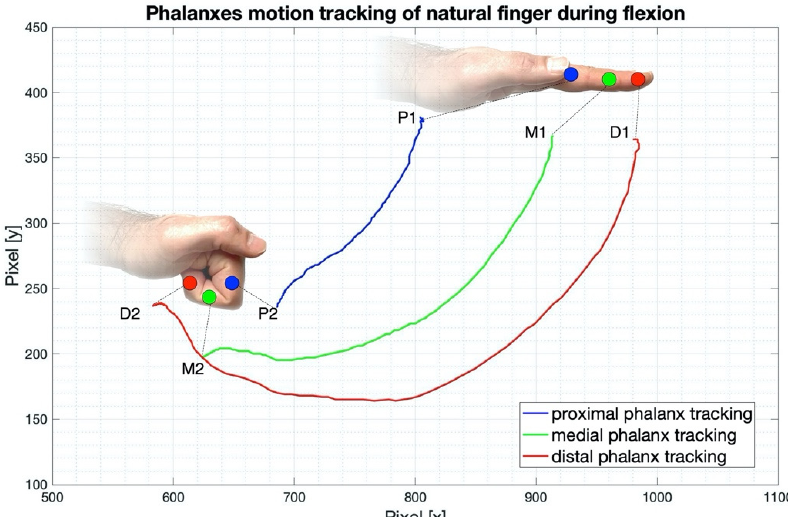
Figure 9. Trajectories described by each phalanx of the index finger (depicted in different colors) of the natural hand during the flexion movement.